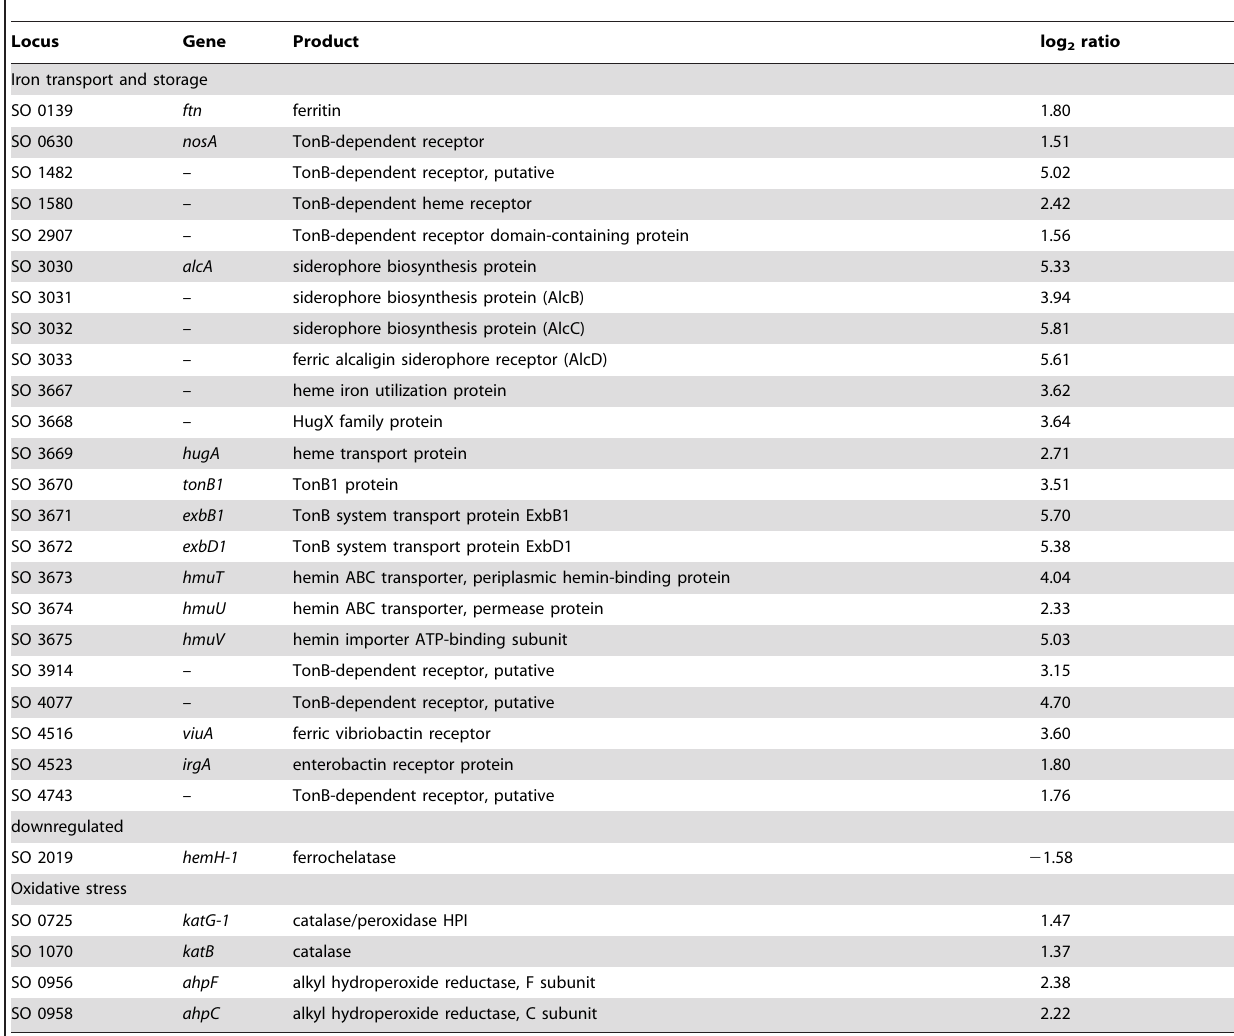
Table 2. Differentially regulated genes potentially related to iron homeostasis.